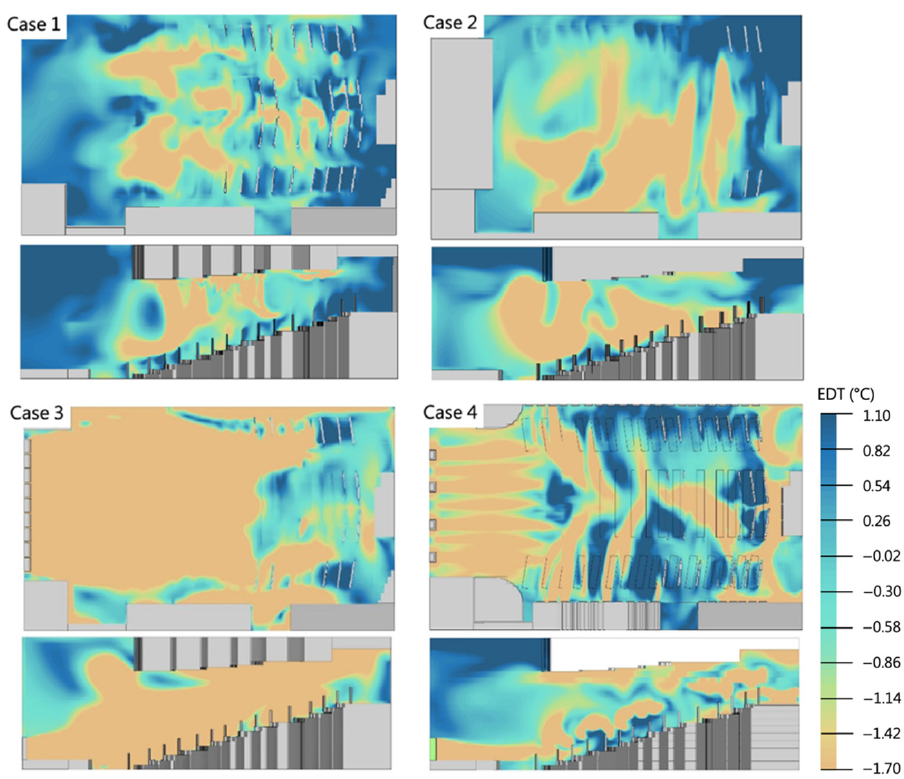
Figure 17. Air velocity distribution of each case.